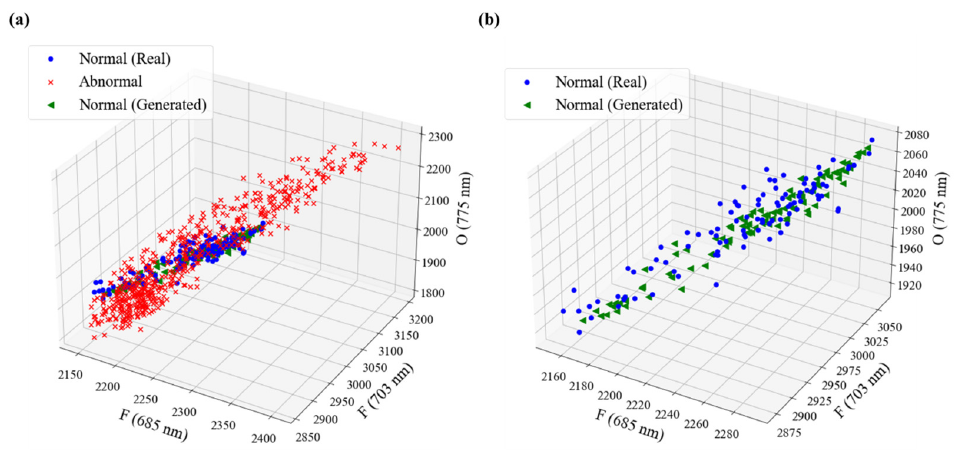
Figure 5. Visualization for generated data using the GAN in the modeling of Case 1; ( a ) real data with generated normal data and ( b ) real normal data and generated normal data.